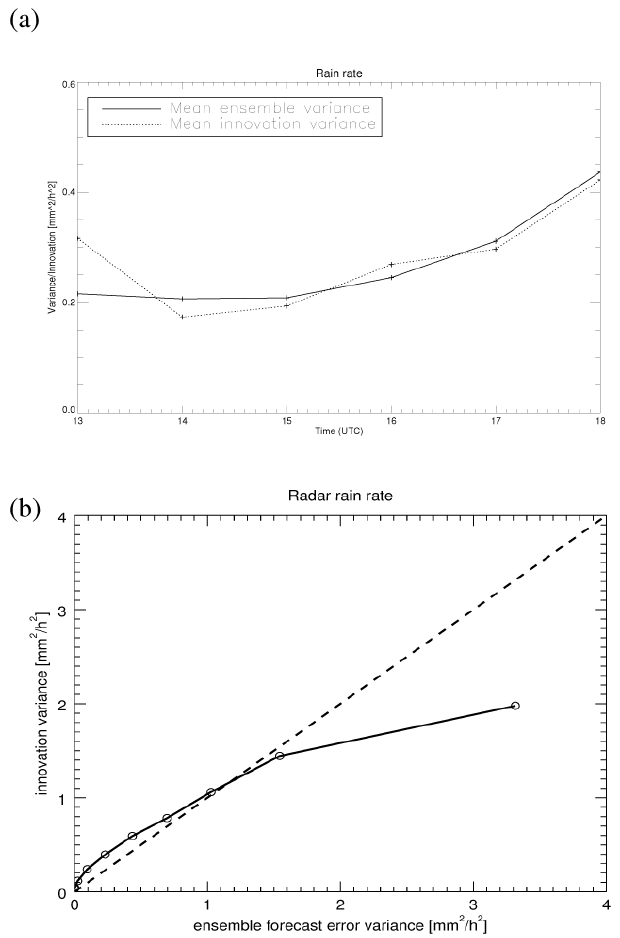
Fig. 10. (a) Domain averaged ensemble variance and innovation variance for rain rate every hour. (b) Spread-skill plot for the con- trol ensemble. In (b) the data for each grid point for each hour of the forecast are binned into 10 bins by ensemble variance.